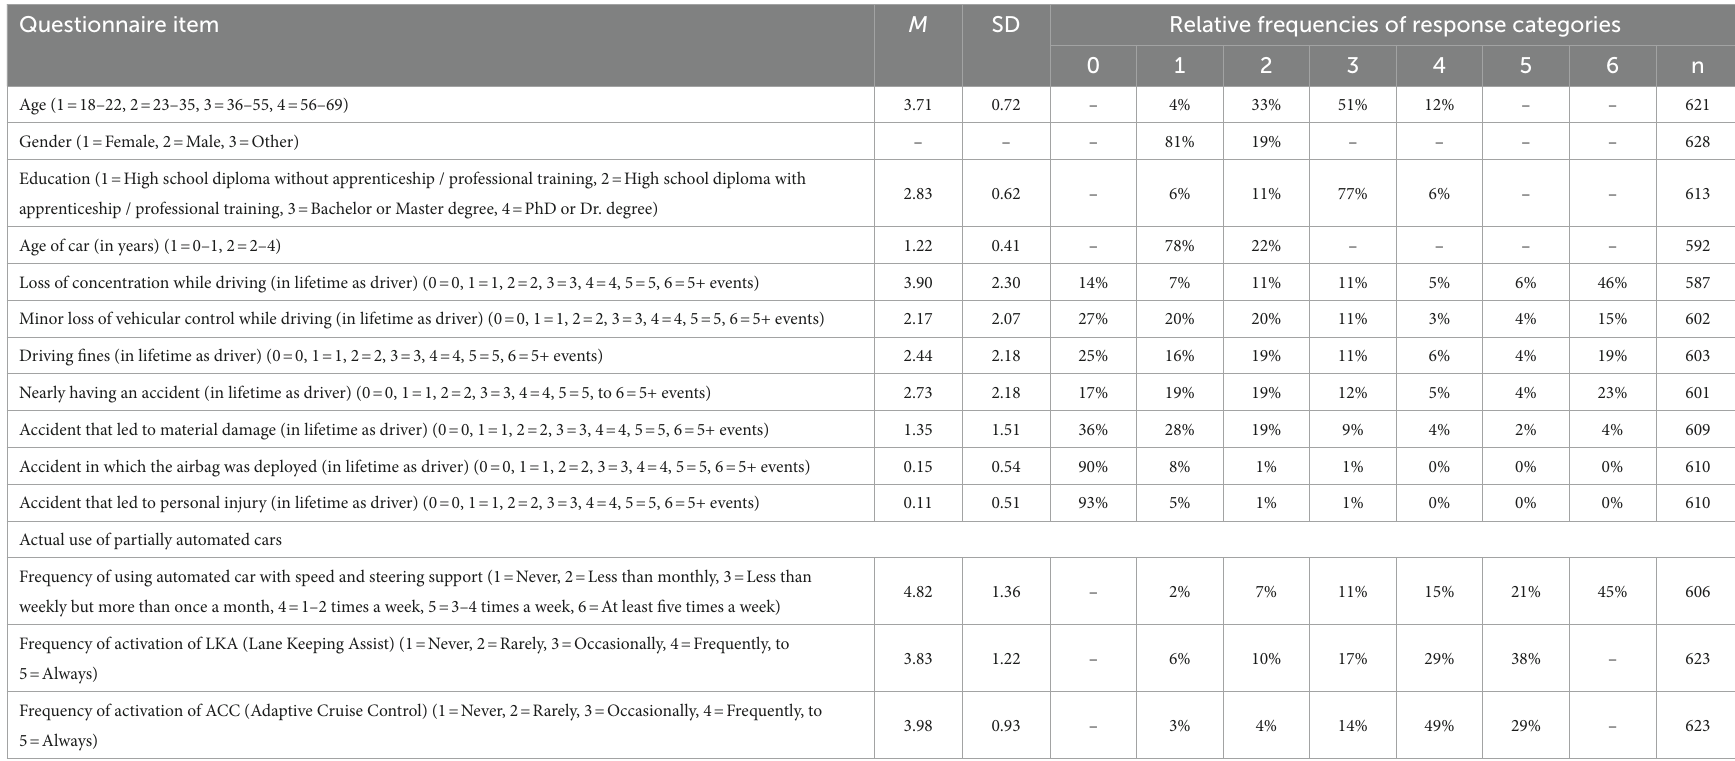
TABLE 3 Respondents’ profile ( M = Means, SD = Standard deviation, n = number of respondents). Questionnaire item M SD Relative frequencies of response